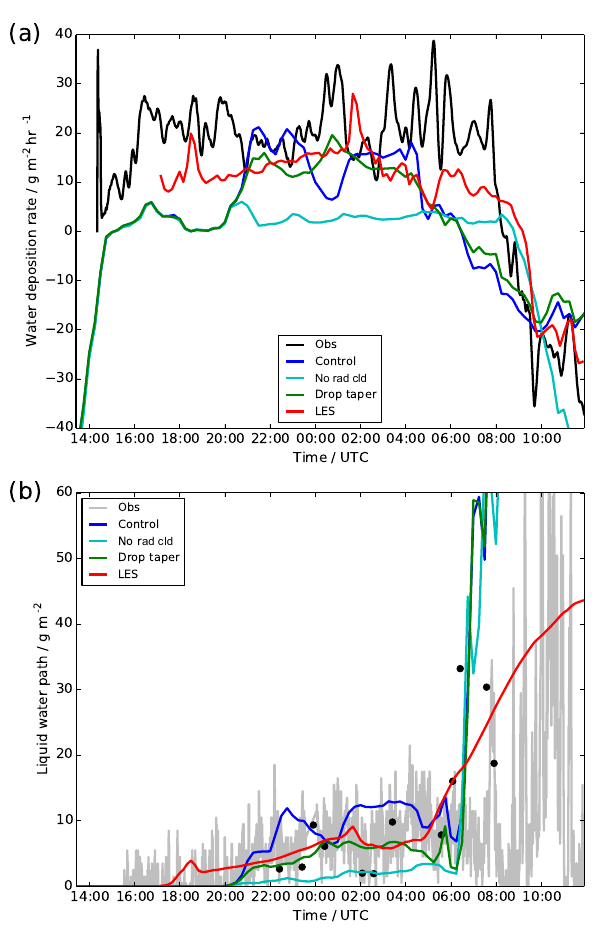
Figure 4. Time series of (a) surface water deposition rate, and (b) liquid water path, showing observations ( a black; b tethered bal- loon: black dots, radiometer: grey line), LES (red) and UKV experi- ments: control (blue), radiatively inactive cloud (cyan) and modified droplet number